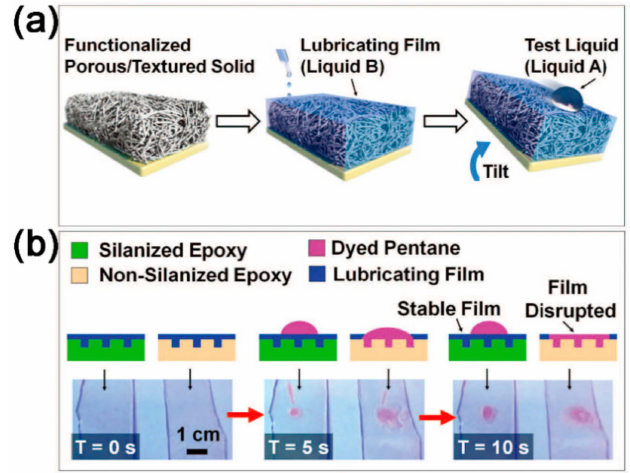
Figure 19. ( a ) Schematic of the structure of the microcapsules and the self-healing mechanisms of the coating. Reprinted from [112] Copyright (2018), with permission from Elsevier; ( b ) Formation process of oil-containing graphene oxide microcapsules (GOMCs) and the processing of GOMCs / PU coatings. Reprinted from [113], Copyright (2017), with permission from Elsevier; ( c , d ) SEM images of self-healing coating before and after healing. Reprinted from [114], Copyright (2009), with permission from John Wiley and Sons.